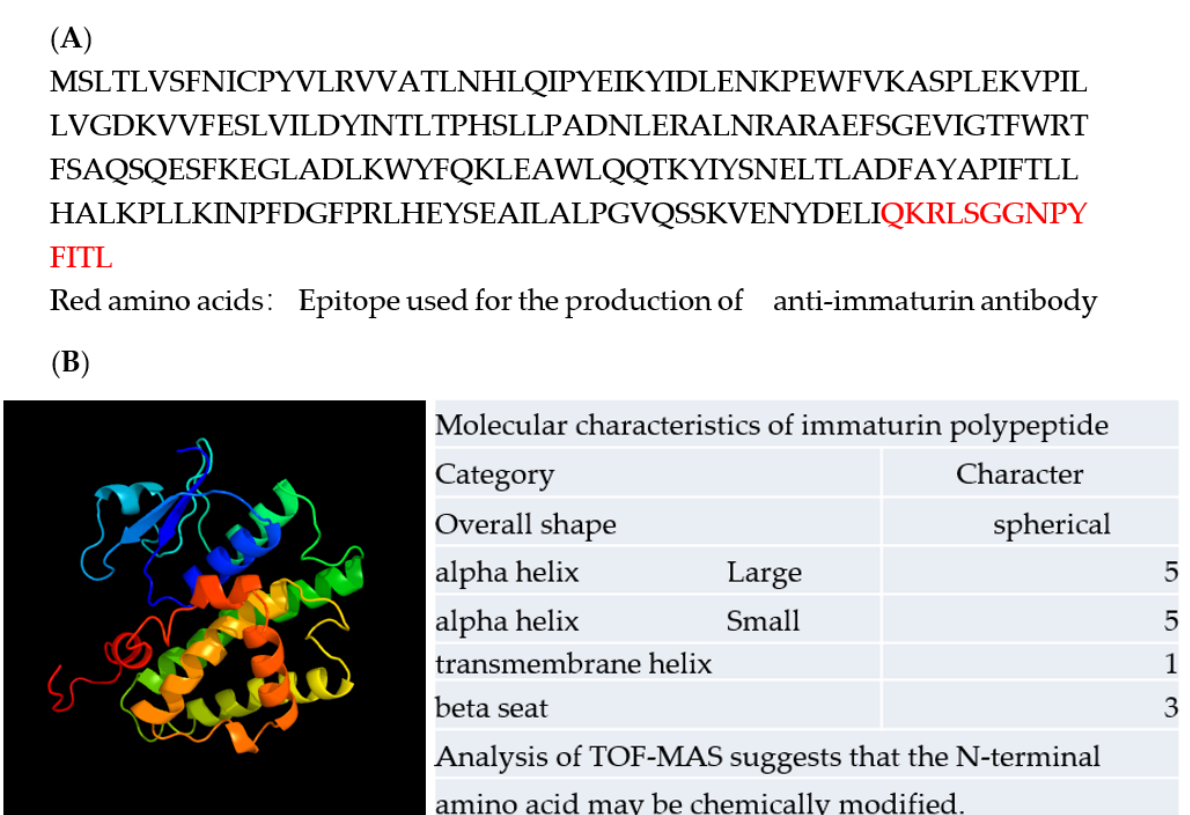
Figure 3. A deduced amino acid sequence of immaturin and molecular information. ( A ) The amino acid sequence QKRLSGGNPYFITL was used as an epitope for the production of the anti-immaturin antibody NH3545. ( B ) A three-dimensional ribbon model of immaturin is displayed (left panel). The N-terminus of the immaturin polypeptide is shown in blue and the C-terminus in red. The ribbon model was produced by the computer graphic software Phyre 2 (protein homology/analogy recognition engine v. 2.0). The total shape deduced from the amino acid sequence of immaturin and the types and numbers of primary structures are shown in the table (right panel).